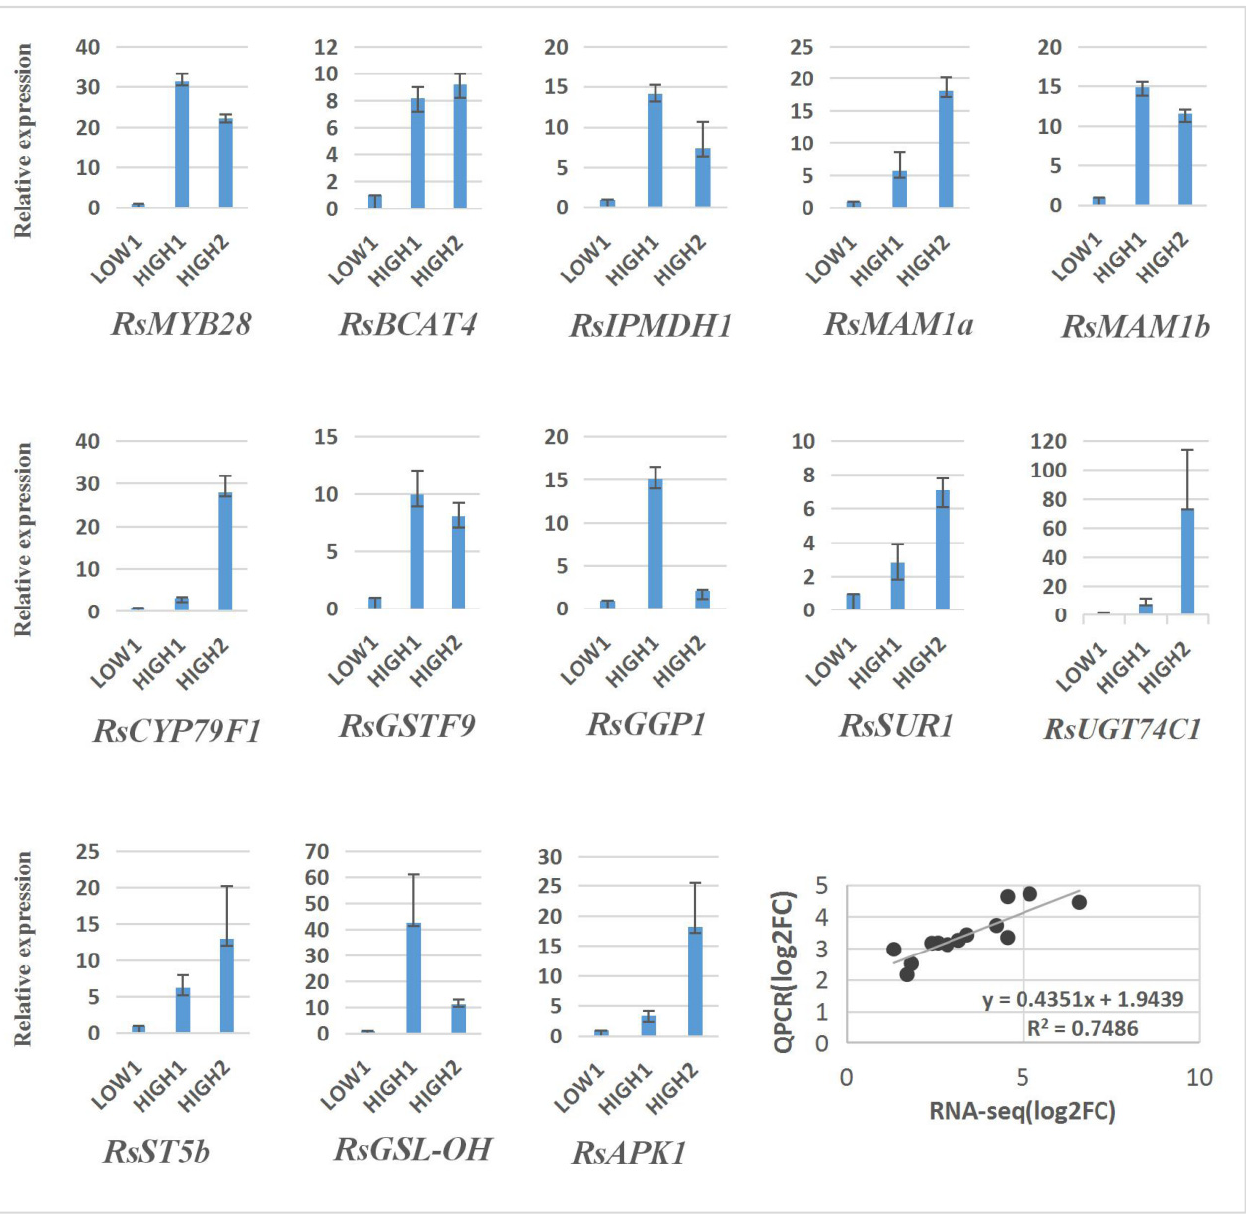
Figure 6. Validation of the expression of 13 differentially expressed genes in LOW1, HIGH1, and HIGH2 fleshy taproots by qRT–PCR. The x axis represents the three cultivar taproots. The y axis shows the relative expression of one specific gene to the reference gene RsGAPDH , and the expression of genes in LOW1 was set to “1” as a control. The last panel shows the results from the RNA-seq/qRT–PCR correlation analysis (bottom right) expressed as log2-fold changes in the low-GSLs vs. high-GSLs genotypes; a significant positive correlation was found between the fold changes in expression, as determined by Pearson’s correlation (R2 = 0.75; p < 0.001).